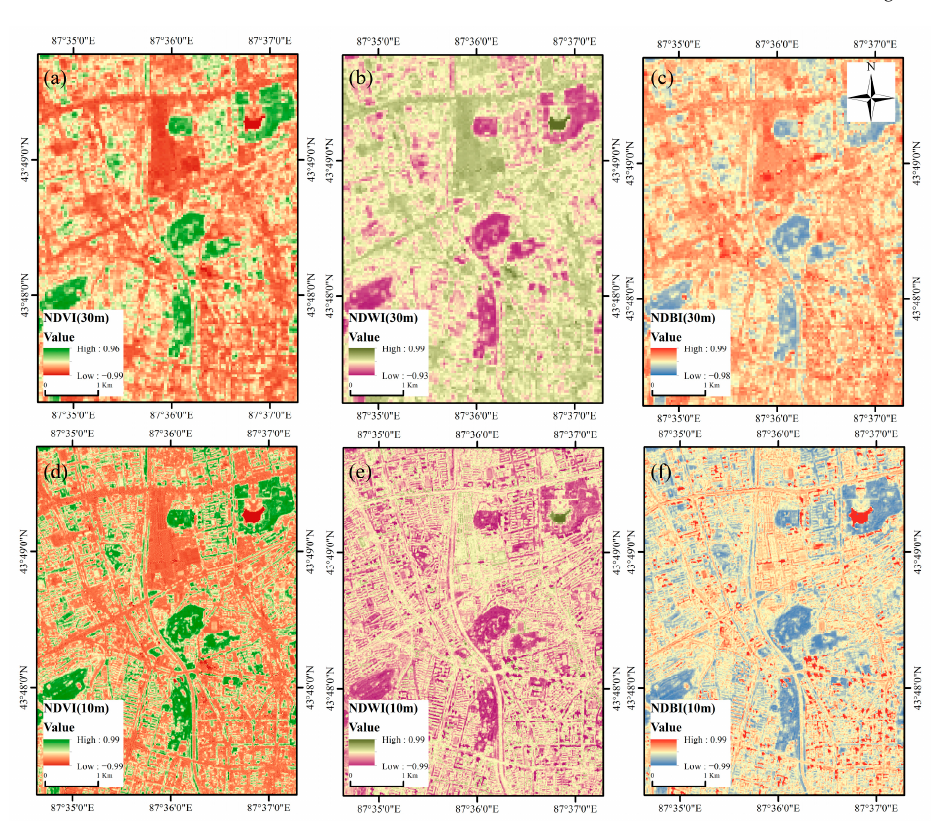
Table 2. LST classification level table. LST Level